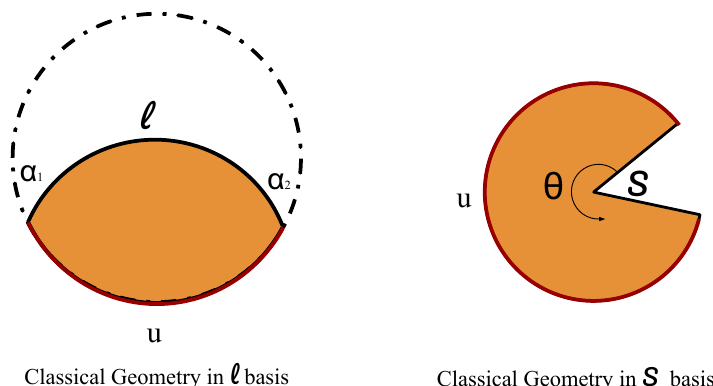
Figure 4 . Classical Geometry in ‘ and S